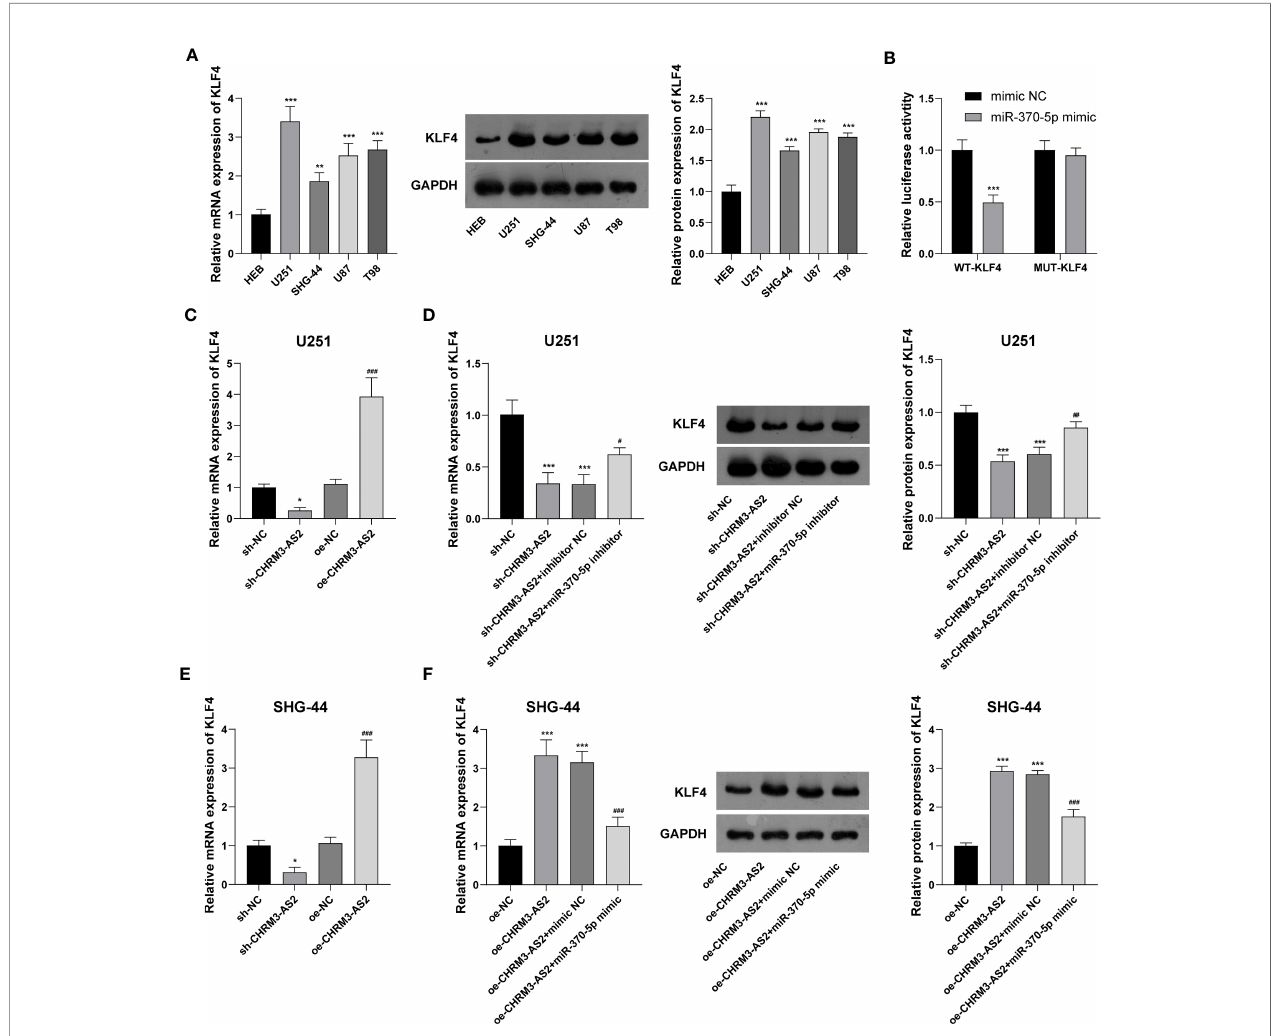
FIGURE 5 | CHRM3-AS2 targeted miR-370-5p/KLF4 axis in glioma cells. (A) KLF4 mRNA and protein expression levels in a normal human glial cell line (HEB) and four glioma cell lines (U251, SHG-44, U87, and T98) were quanti fi ed via qRT-PCR and western blotting, respectively. **P < 0.01, ***P < 0.001 vs. HEB. (B) The relationship between miR-370-5p and KLF4 was determined via DLR assays; ***P < 0.001 vs. mimic NC. (C) KLF4 mRNA expression in U251 cells transfected with sh-CHRM3- AS2/sh-NC or oe-CHRM3-AS2/oe-NC was quanti fi ed via qRT-PCR; *P < 0.05 vs. sh-NC; ### P < 0.001 vs. oe-NC. (D) KLF4 mRNA and protein expression in U251 cells transfected with sh-CHRM3-AS2/sh-NC and miR-370-5p inhibitor/inhibitor NC was quanti fi ed via qRT-PCR and western blotting, respectively. ***P < 0.001 vs. sh-NC; # P < 0.05, ## P < 0.01 vs. sh-CHRM3-AS2. (E) KLF4 mRNA in SHG-44 cells transfected with sh-CHRM3-AS2/sh-NC or oe-CHRM3-AS2/oe-NC was quanti fi ed via qRT- PCR; *P < 0.05 vs. sh-NC; ### P < 0.001 vs. oe-NC. (F) KLF4 mRNA and protein expression in SHG-44 cells transfected with oe-CHRM3-AS2/oe-NC and miR-370-5p mimic/mimic NC was quanti fi ed via qRT-PCR and western blotting, respectively. ***P < 0.001 vs. oe-NC; ### P < 0.001 vs.